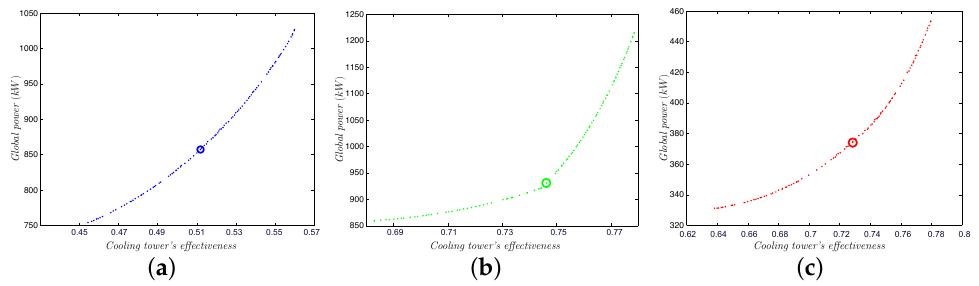
Figure 5. Pareto fronts and selected optimal solutions for 3 of the 35 operating points used in the implementation of the optimization with NSGA-II with stopping criterion after 50 iterations. ( a ) Operational point 8; ( b ) Operational point 16; ( c ) Operational point 26.